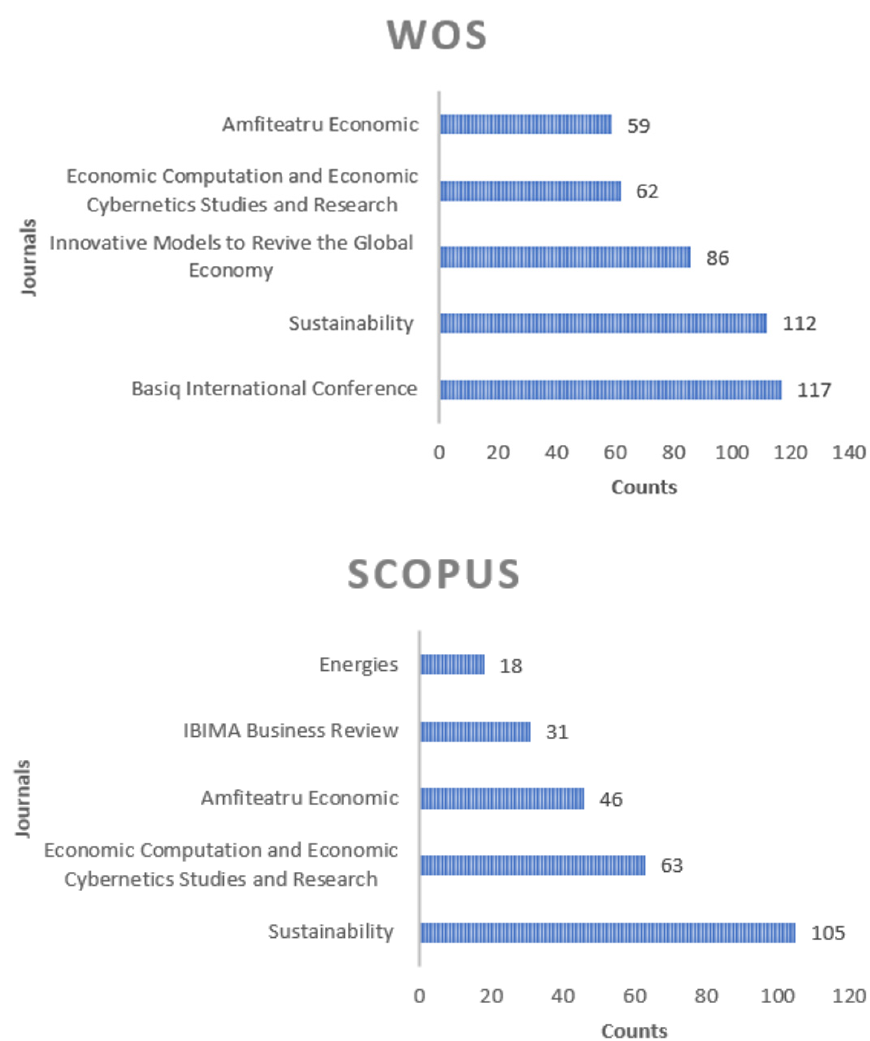
Figure 1. Top journals in both WoS and Scopus by the number of published papers. Analysing now the distribution of journals in both databases: Scopus and WoS, by the subject areas, it can be observed that most of the journals indexed in WoS are in the categories of Business and Economics, while, in Scopus, we encountered mostly journals from Economics and Social Sciences (Figure